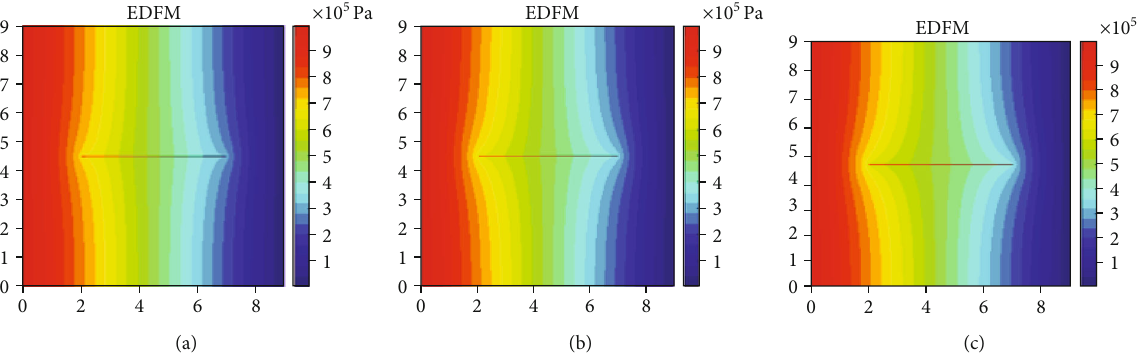
Figure 4: Pressure contours (in Pa) generated from EDFM. The fl ow is driven by the Dirichlet boundary conditions of 10 7 Pa and 0 Pa at the right and left faces, respectively. The matrix permeability is 10 mD, and the permeability contrasts ( k f / k m ) are (a) 50, (b) 100, and (c) 150.